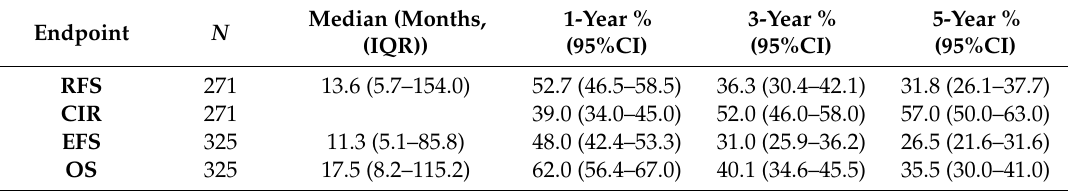
Figure 1. Outcome of patients with newly diagnosed FLT3 -mutated acute myeloid leukemia: ( A ) relapse-free survival; ( B ) cumulative incidence of relapse; ( C ) event-free survival; ( D ) overall survival. Table 2. Survival of FLT3 -mutated acute myeloid leukemia after first-line FLT3 inhibitor-free intensive chemotherapy.